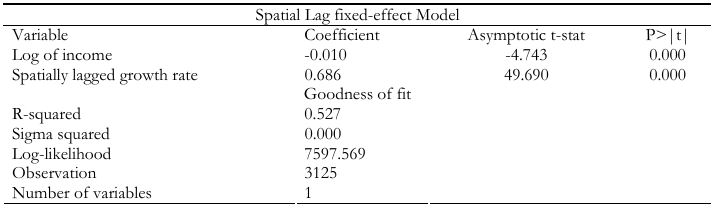
Convergence of per capita income in the 125 European regions (1977-2002) - Estimation of the fixed-effect Spatial Lag Model Equation (3) - (numbers into brackets refer to the p-values)